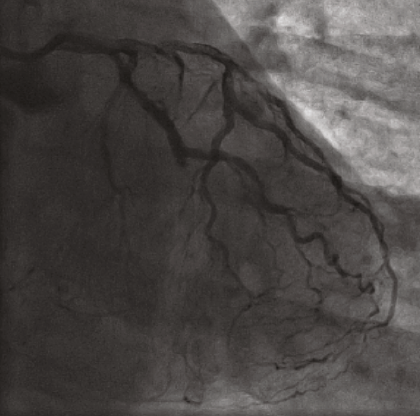
Figure 5: In-stent thrombosis of the left circum fl ex artery (LCx).